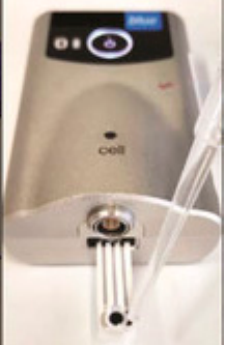
Figure 1. A portable electrochemical device for on-site detection of illicit drugs. The deposition of the solution on its connected SPE is shown [46]. Adapted from MDPI under a Creative Common CC BY